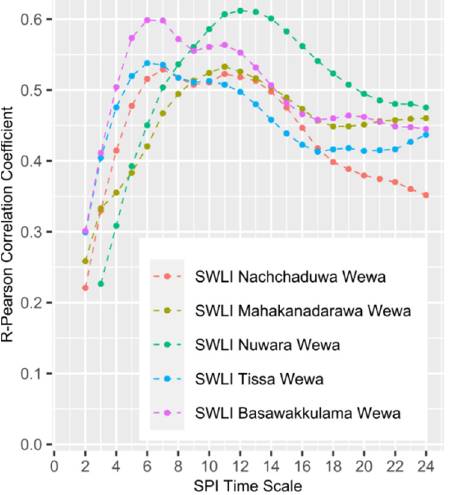
Figure 6. Pearson R correlation values for the SPI time scales 2–24 months and SWLI for each tank (points = calculated Pearson R correlation values).